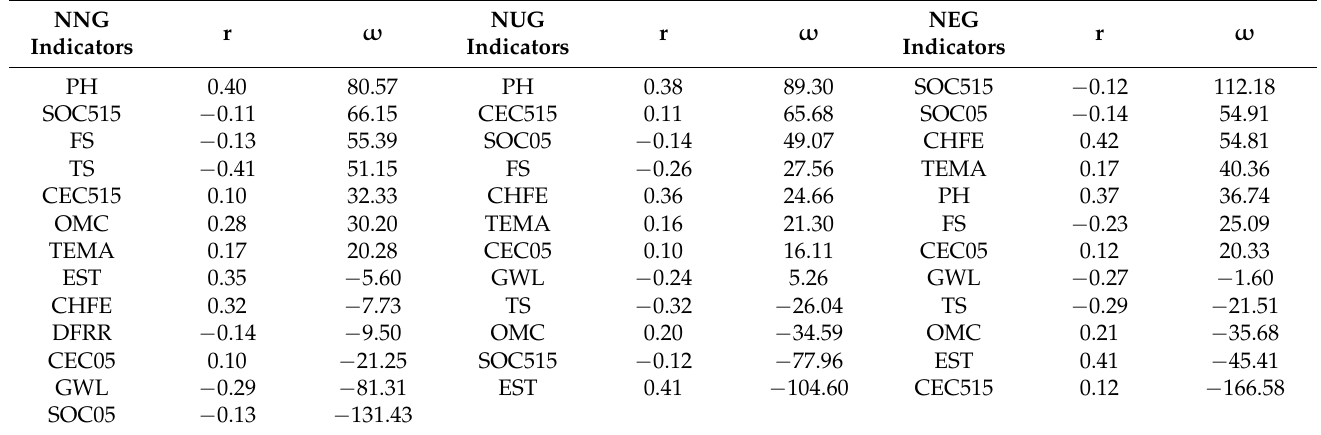
Table 2. Cultivated land quality evaluation